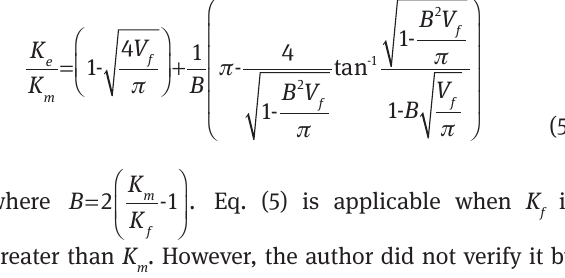
Figure 2. The dashed frames in Figure 2 represent the unit cell of fibre arrays. It is assumed that the fibres are impreg­ nated in a fluid phase (air, water or resin). The thermal contact resistance at the fibre/fluid interface is assumed to be zero. In Figure 2A, the side length of unit cell and the fibre radius are supposed to be 2 and R ( R ≤ 1),